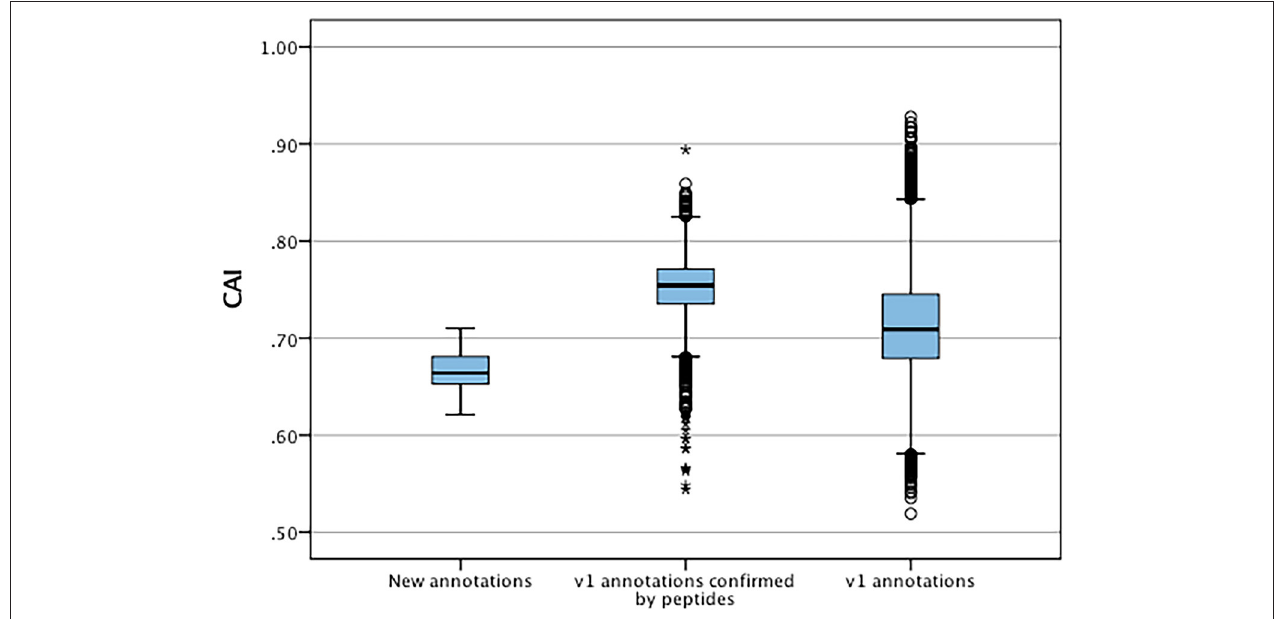
FIGURE 5 | Distribution of codon adaptation indices between new annotation and V1.0 annotations confirmed by mass spectrometry and all V1.0 annotations. *Represent significant differences ( p < 0.05) of data sets to V1.0 annotations.